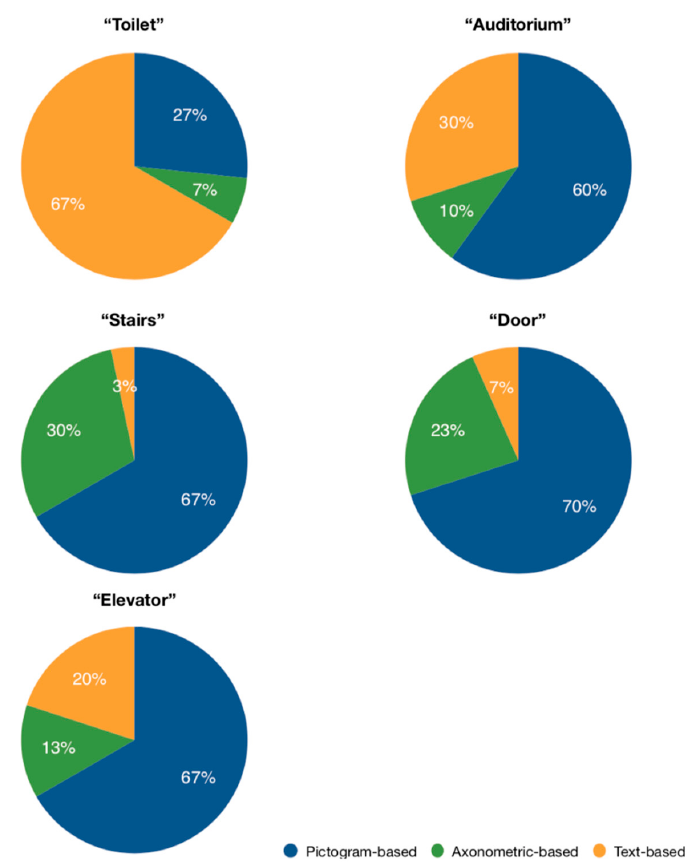
Figure 25. Participants’ preferences regarding landmarks’ visualization design approach.